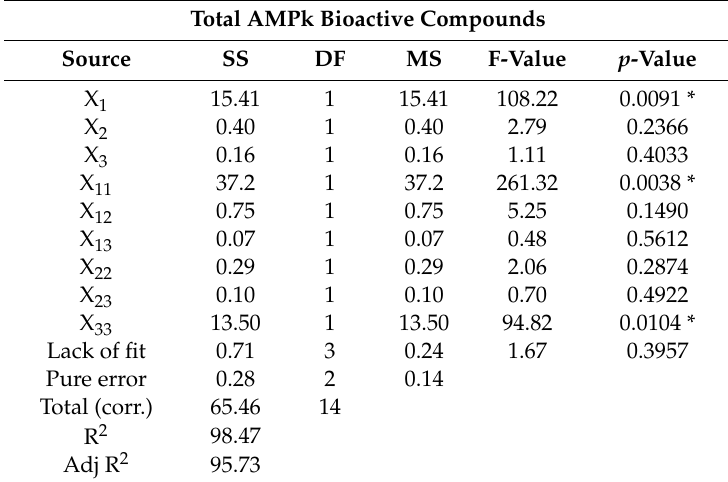
Table 4. ANOVA test for the response variable of total AMPK bioactive compounds. Total AMPk Bioactive